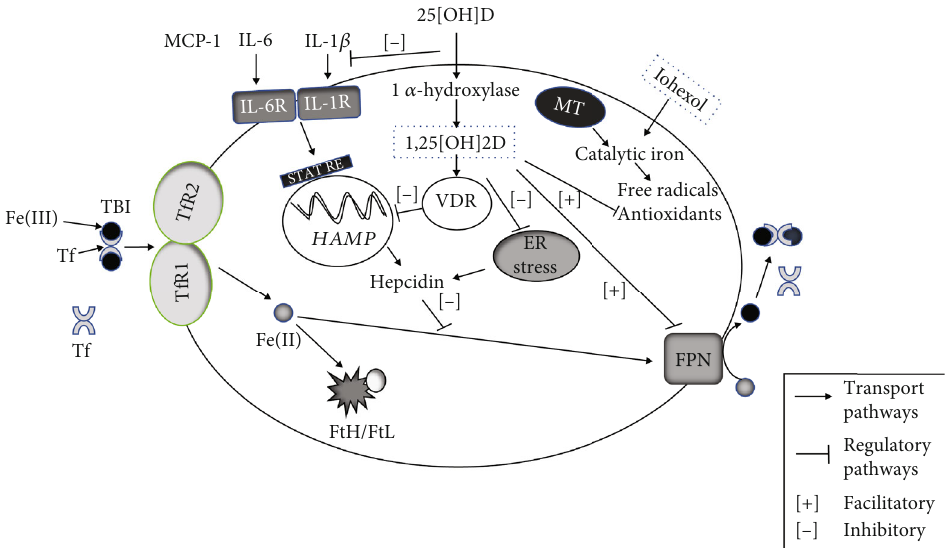
Figure 8: Mechanistic diagram illustrating the renoprotective role of calcitriol in iohexol-induced AKI. Iohexol increases the intracellular release of catalytic iron, for example, from mitochondria (MT) during the process of renal tissue injury. Concurrently, 1 α -hydroxylase (CYPB21) catalyses the conversion of 25-hydroxyvitamin D3 (25[OH]D) to active 1,25-dihydroxyvitamin D3 (I,25[OH]2D3), also known as calcitriol. Calcitriol binds to vitamin D receptor (VDR) which then binds to the proximal promoter region of HAMP gene containing vitamin D-responsive elements (VDREs) leading to suppression of HAMP gene and therefore hepcidin protein expression directly [112]. Vitamin D also indirectly reduces prohepcidin in fl ammatory cytokines, IL-6 and IL-1 β [113] and MCP-1 [114]. Furthermore, vitamin D possesses antioxidant property and it relieves endoplasmic reticulum stress which is an inducer of hepcidin expression that could result in dysregulated cellular iron homeostasis [115]. Transferrin-bound iron (TBI) enters the cytosol through transferrin receptor protein (TfR1 and TfR2) and is either oxidized by ferritin heavy chain (FtH) to be stored intracellularly in the ferritin complex consisting of ferritin heavy and light chains (FtH/FtL) or is exported out of the cell by ferroportin (FPN). Hepcidin, the key regulator of systemic and cellular iron homeostasis, facilitates internalization and degradation of ferroportin. 25[OH]D: 25-hydoxyvitamin D3; 1,25[OH]2D: 1,25- dihyroxyvitamin D3; VDR: vitamin D receptor; MCP-1: monocyte chemoattractant protein 1; IL-6: interleukin 6; IL-1 β : interleukin 1 β ; IL-6R: interleukin 6 receptor; IL-1 β R: interleukin 1 β receptor; STAT RE: signal transducer and activator of transcription responsive element; HAMP: hepcidin antimicrobial peptide; ER stress: endoplasmic reticulum stress; MT: mitochondria; Fe(III): ferric iron; Tf: transferrin; TBI: transferrin-bound iron; TfR1: transferrin receptor protein 1; TfR2: transferrin receptor protein 2; Fe(II): ferrous